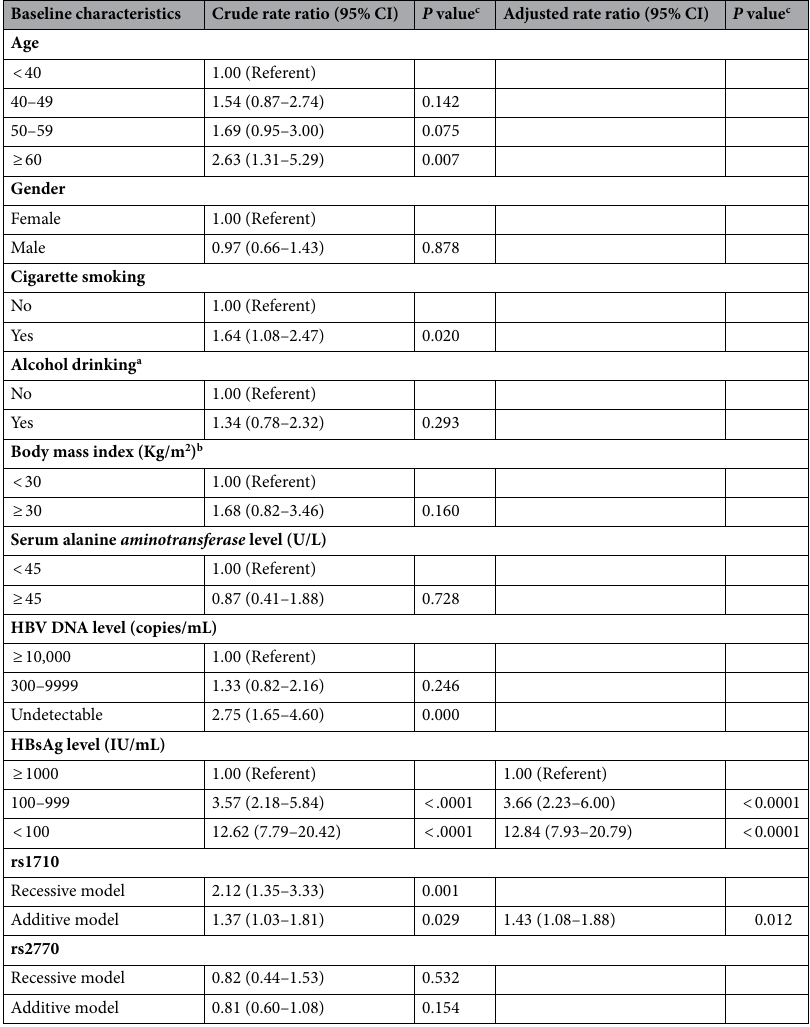
Table 4. Multiple predictors for the seroclearance of HBsAg in HBeAg-seronegative chronic hepatitis B patients with genotype C HBV infection. a One participant was missing for the data of habitual drinking status. b One participant was missing for the data of body mass index. c Estimated by Cox proportional hazards